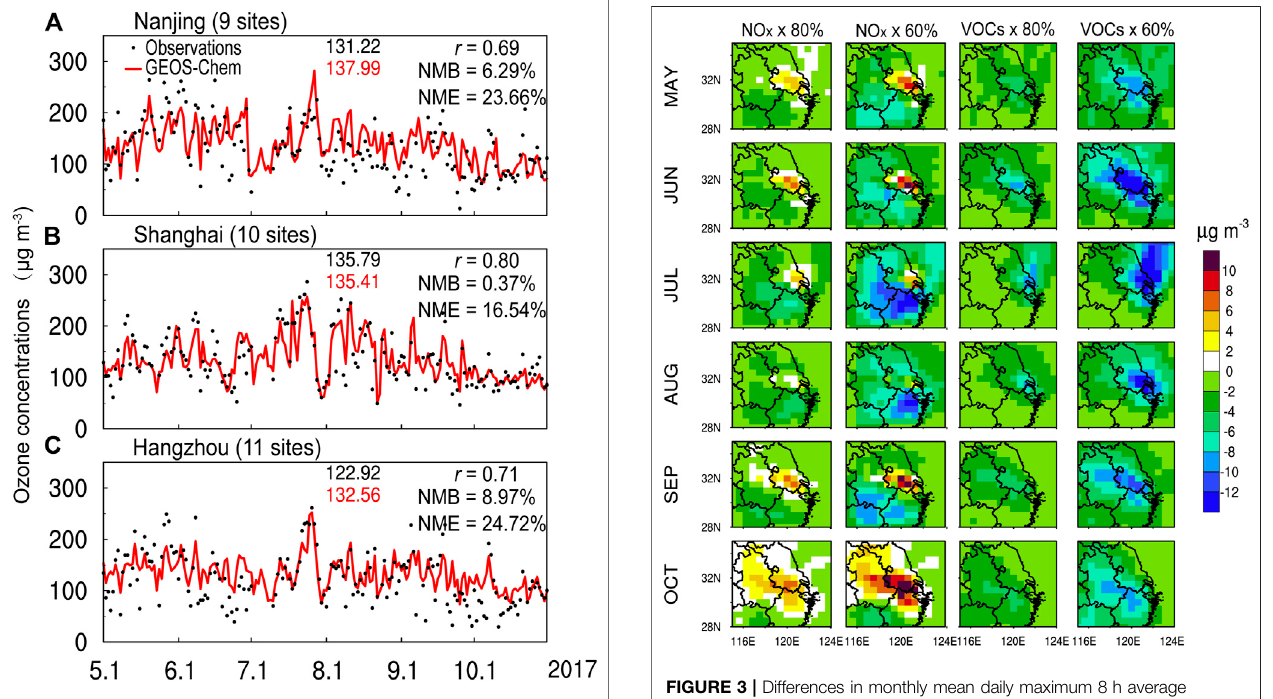
FIGURE 2 | Observed (black) and simulated (red) daily maximum 8 h average (MDA8) ozone concentrations ( μ g m − 3 ) averaged for stations at (A) Nanjing (9 sites), (B) Shanghai (10 sites), and (C) Hangzhou (11 sites) from May to October 2017. Also shown are observed and simulated mean ozone concentrations for the time period, correlation coef fi cients ( r ), normalized mean bias (NMB), and normalized mean errors (NME) between model results and observations. All the correlation coef fi cients pass the two- tailed t -test with 95% con fi dence interval.